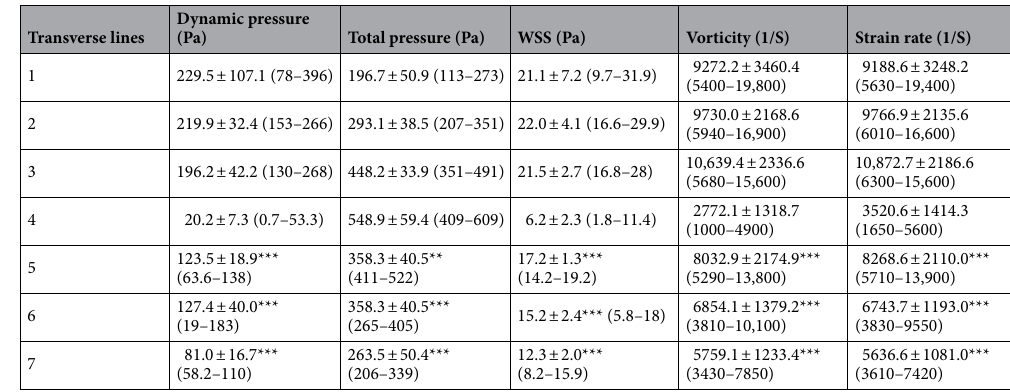
Table 5. Hemodynamic stresses on 7 transverse lines at the ACA bifurcation after virtual aneurysm removal (mean ± SD). SD standard deviation. Blood flow direct impinging center is on line 4. ** P < 0.01 and *** P < 0.001 represent significant differences in hemodynamic parameters between lines 1 and 7, lines 2 and 6, and between lines 3 and 5.